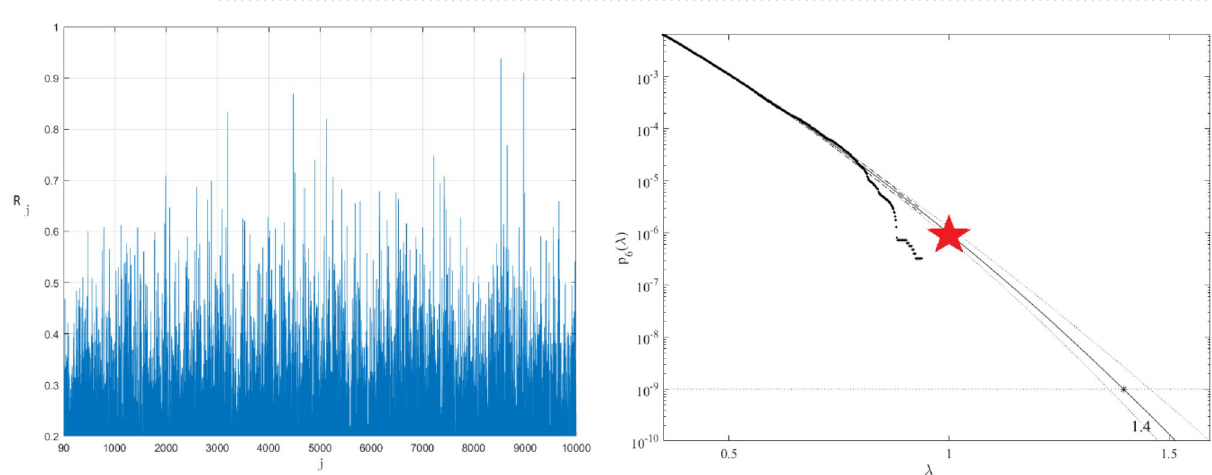
Figure 4. Left: Example of non-dimensional assembled 3D vector −→ R . Right: Extrapolation of p k ( (cid:31) ) towards 6 . Extrapolated 95% CI indicated by dotted critical level (indicated by a star) and beyond, k =